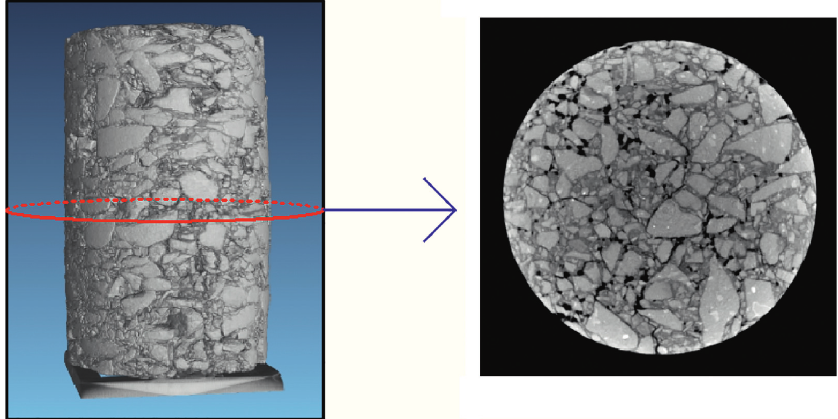
Figure 1: Images of asphalt mixtures specimen scanned using CT X-ray.